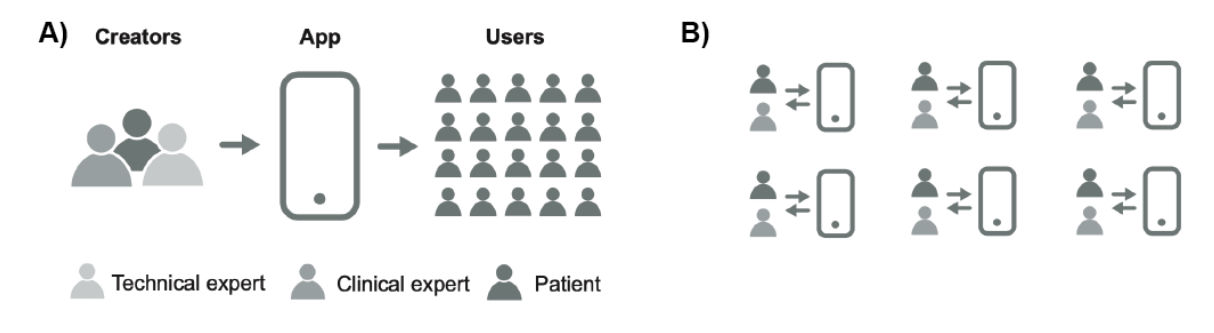
Figure 1. Comparison of two approaches to the participatory technology development process for mobile apps. A) Stakeholders cocreate an app for a group of end users. B) Patients and providers cocreate apps to support